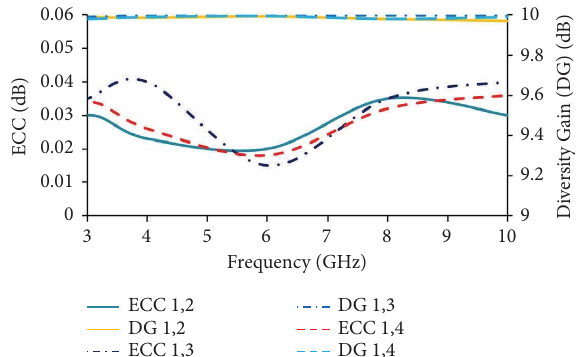
Figure 17: ECC and DG plots of the MIMO antenna.